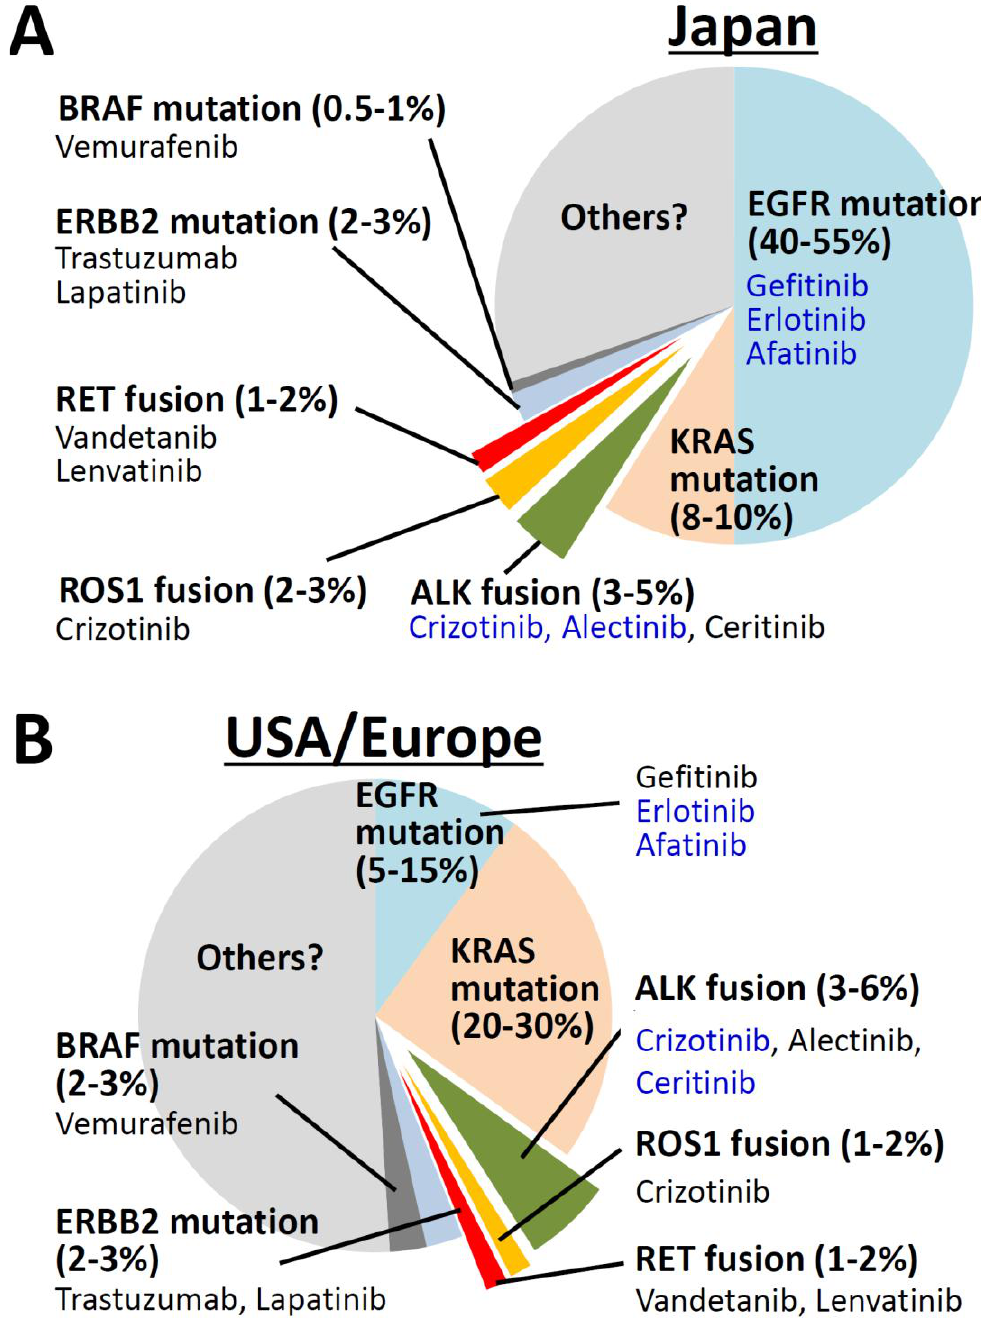
Figure 1. Mutually exclusive occurrence of oncogene aberrations in lung adenocarcinomas (LADC). Data on patients in Japan ( A ) and of European descent ( B ) were generated by summarizing the results of previous reports. Molecular target drugs for each oncogene aberrations are shown in blue (approved for lung cancer) or black (in clinical or preclinical studies). Anaplastic lymphoma kinase ( ALK ), c-ros oncogene 1 ( ROS1 ), and rearranged during transfection ( RET ) oncogene fusions are present in a subset of LADCs in both